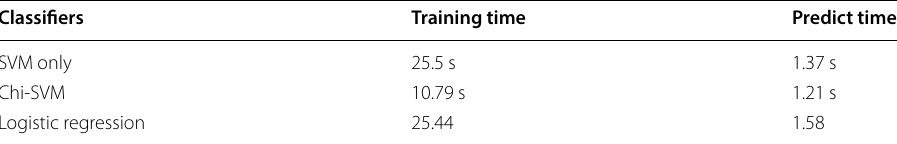
Table 6 Training and predict time